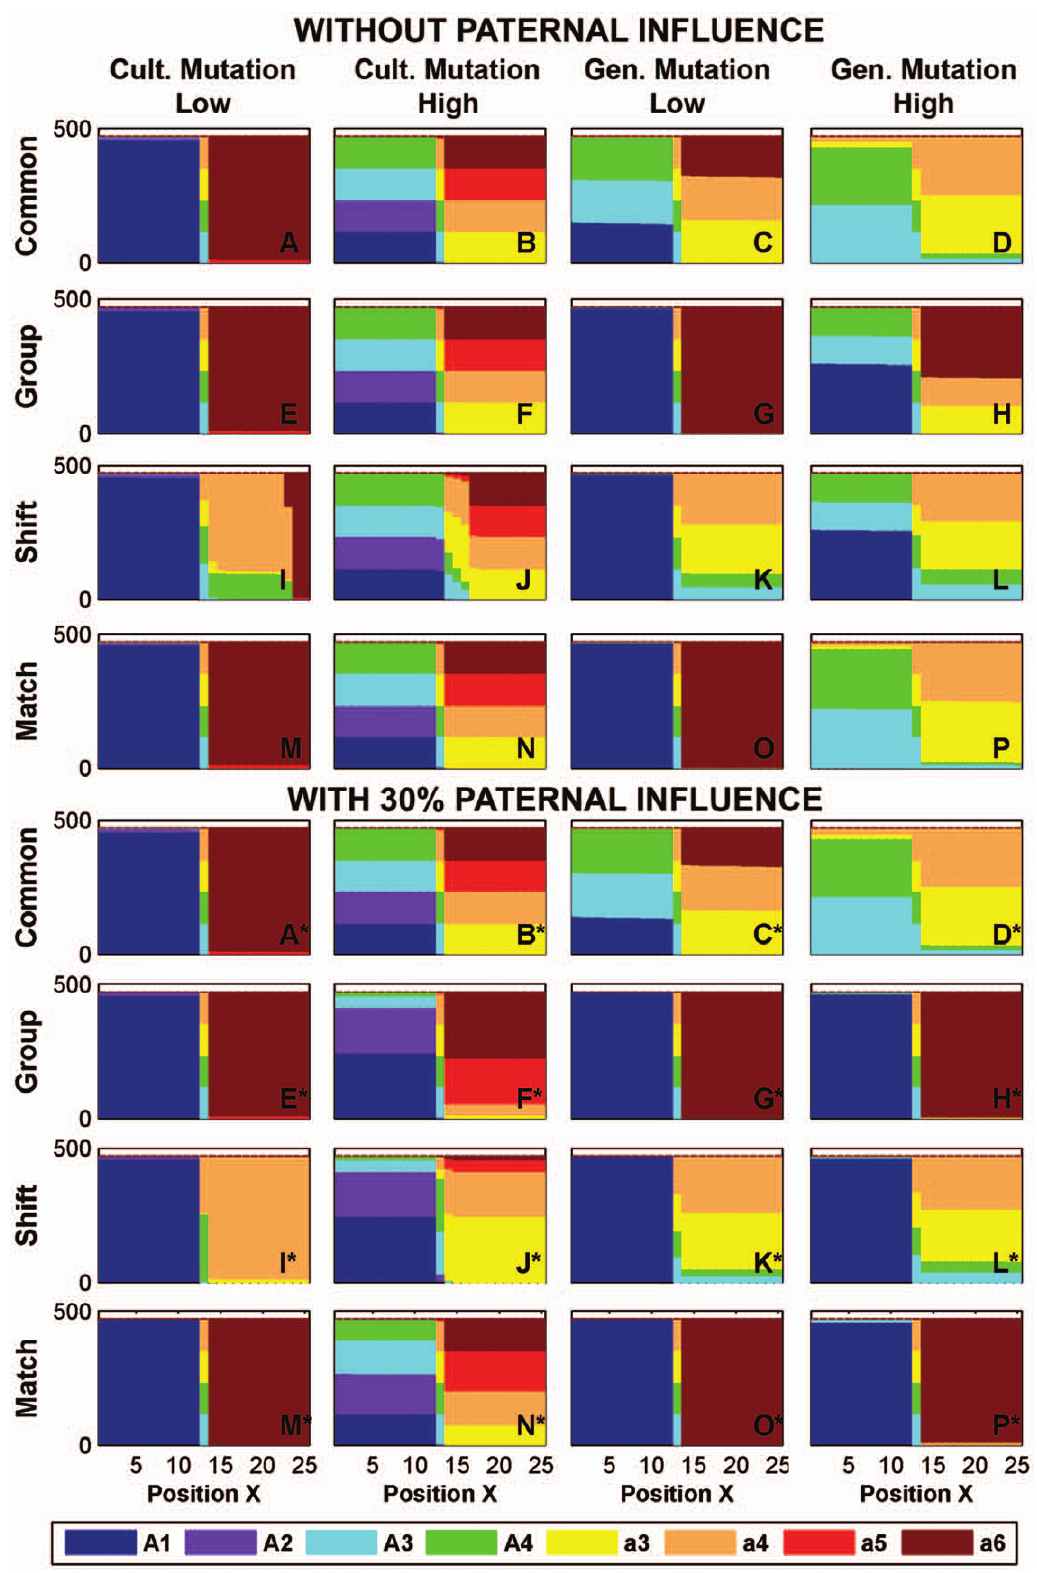
Figure 4. Area I under cultural or genetic mutations. Panels here are as those described in Figure 3. v 1 =10 2 4 , v 2 =10 2 6 in all panels. Rows correspond to the affinity schemes Common, Group, Shift, and Match, respectively. Column 1: c 1 =.01%; Column 2: c 1 =5%; Column 3: c 2 =10 2 6 ; and Column 4: c 2 =10 2 4 . All other parameters assumed 0. Panels A*–P* show the effect of adding 30% paternal transmission to learning.